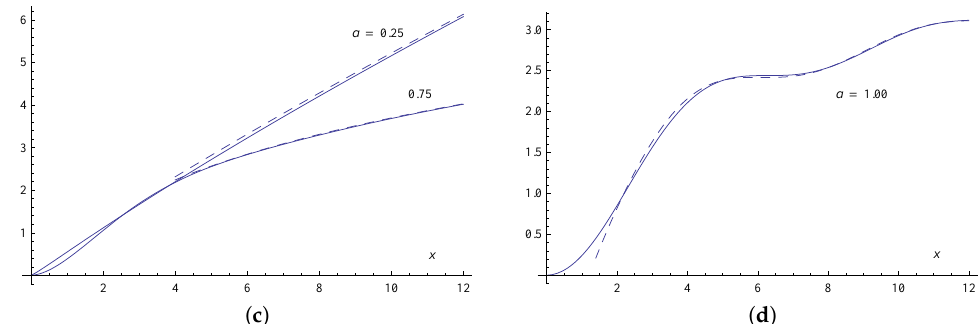
Figure 4. Plots of the generalised sine and cosine integrals (solid curves) and their leading asymptotic approximations (dashed curves) from Theorems 3, 4 and 5: ( a ) Sin α ,1 ( x ) when α = 0.25,0.75, ( b ) Sin α ,1 ( x ) when α = 1, ( c ) Cin α ,1 ( x ) when α = 0.25,0.75 and ( d ) Cin α ,1 ( x ) when α =